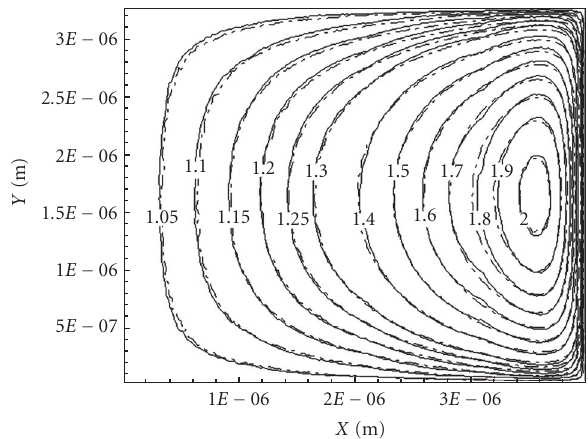
Figure 7: The contours of p/p 0 for H min = 10nm and U = 25m / s. Solid line: IP; dashed line: DSMC, cited from [37].